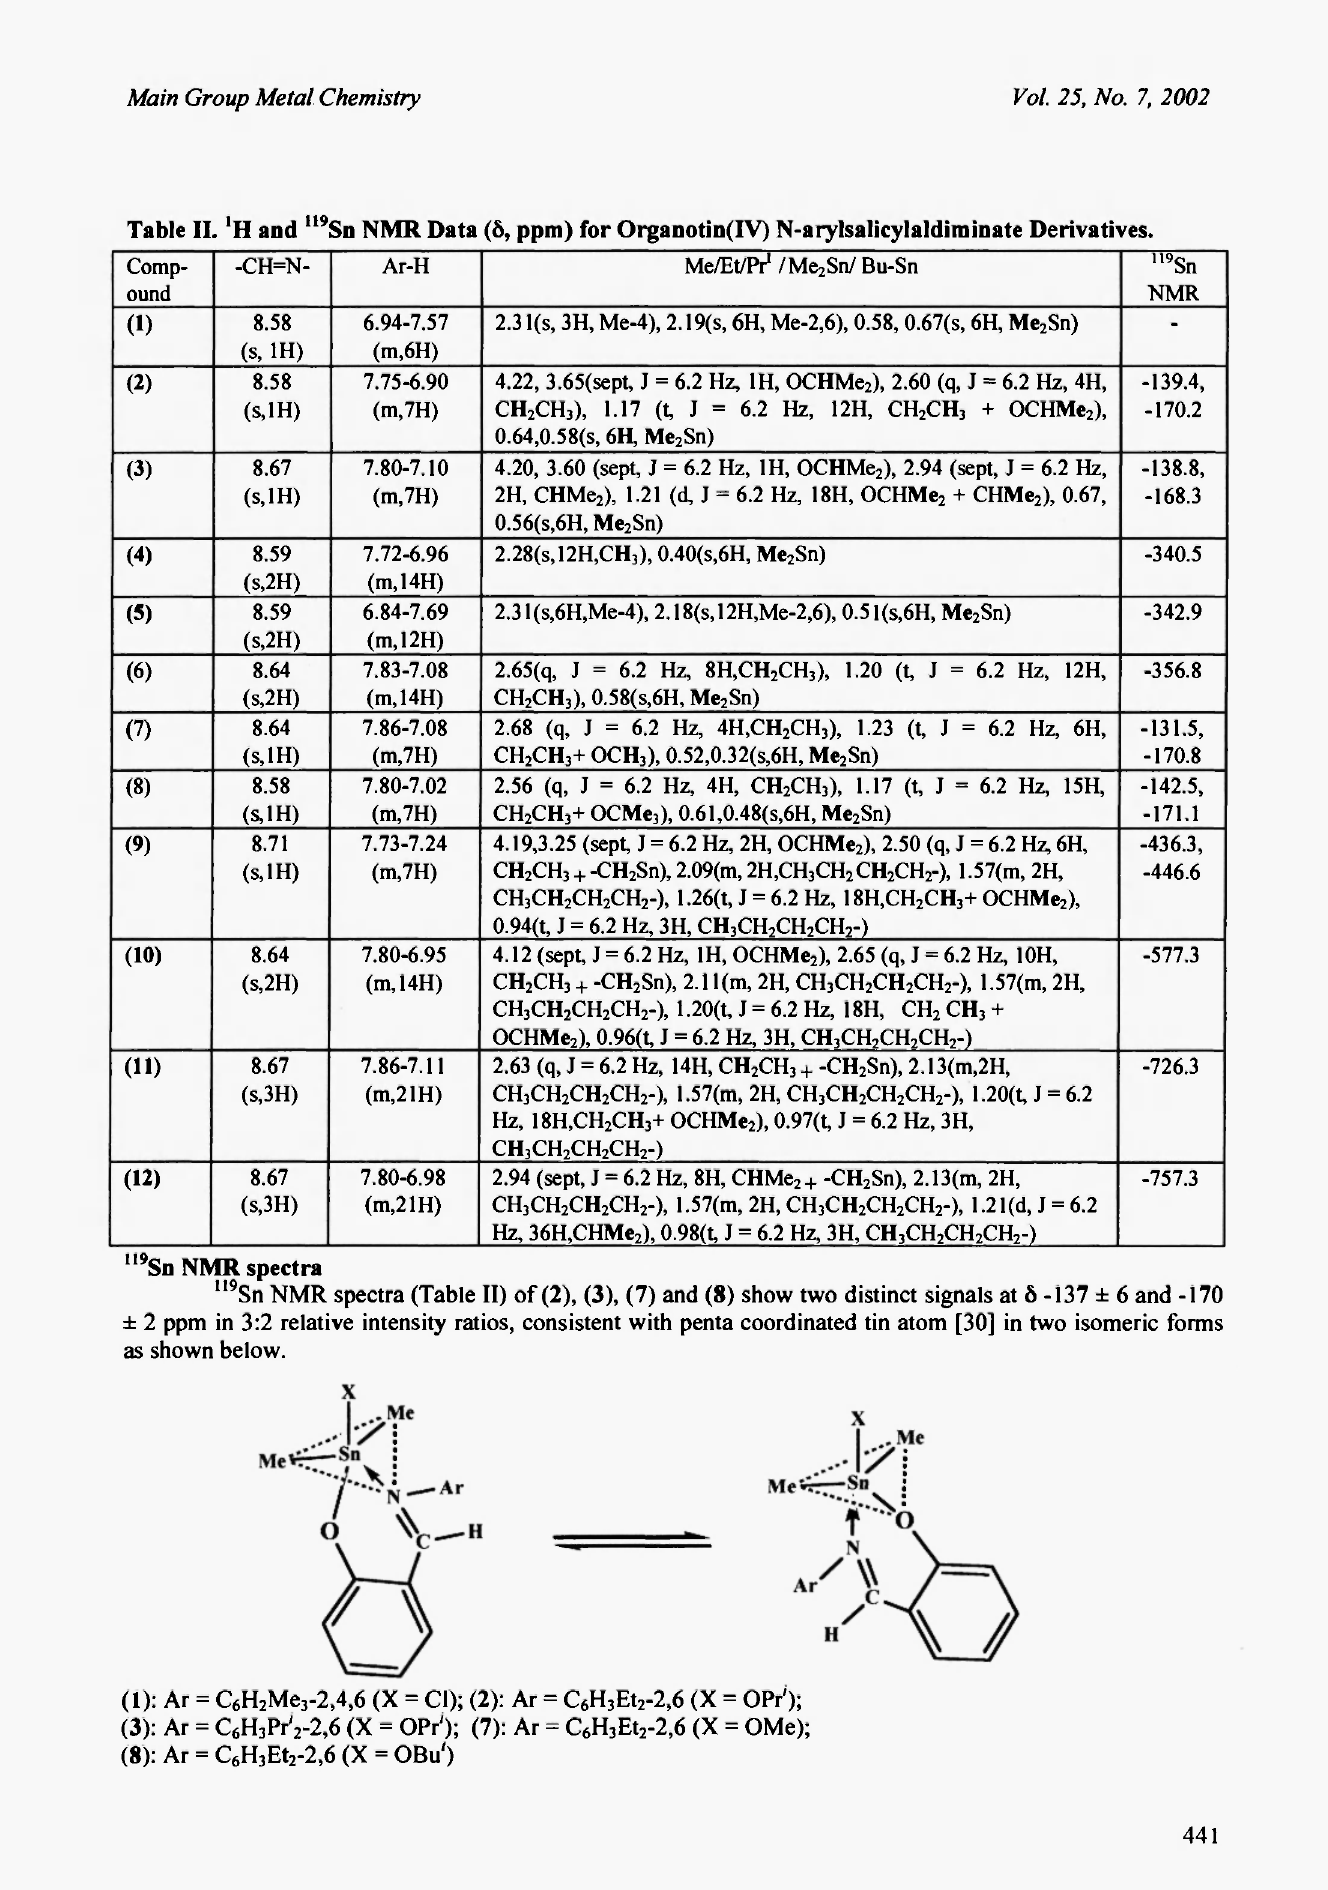
Table II. 'H and ll9 Sn NMR Data (δ, ppm) for Organotin(IV) N-arylsalicylaldiminate Derivatives. Comp-